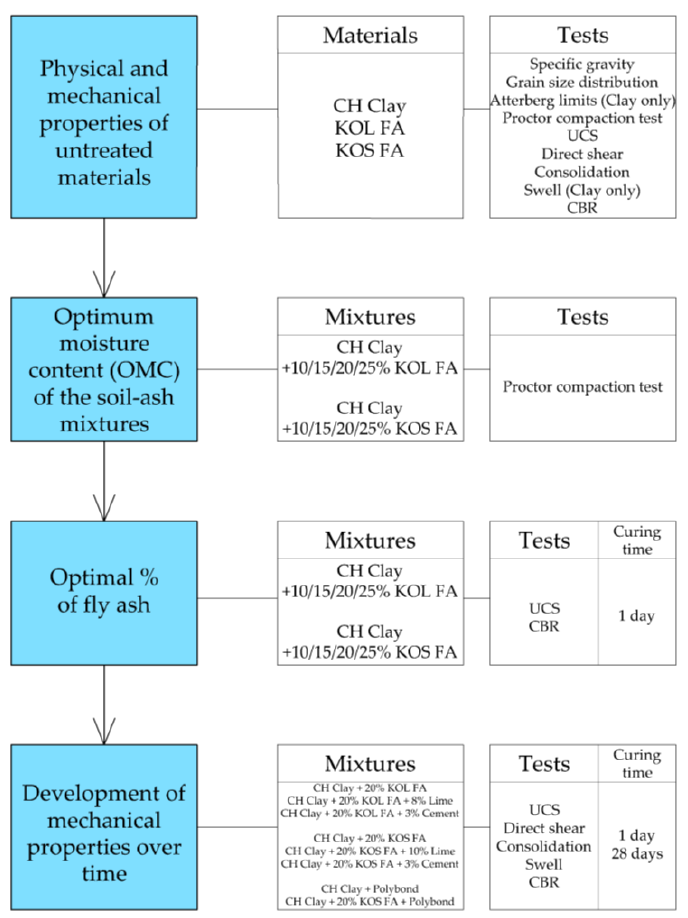
Figure 1. Flowchart of the laboratory testing program—high plasticity clay stabilization.